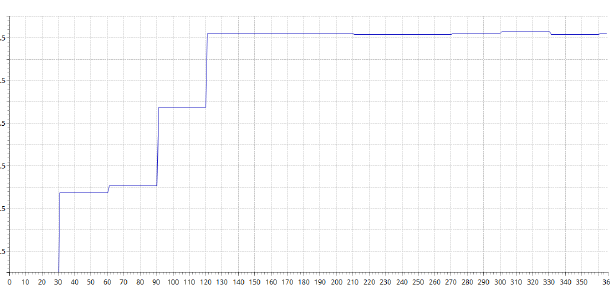
Figure 22. Lead-Time of Scenario II.